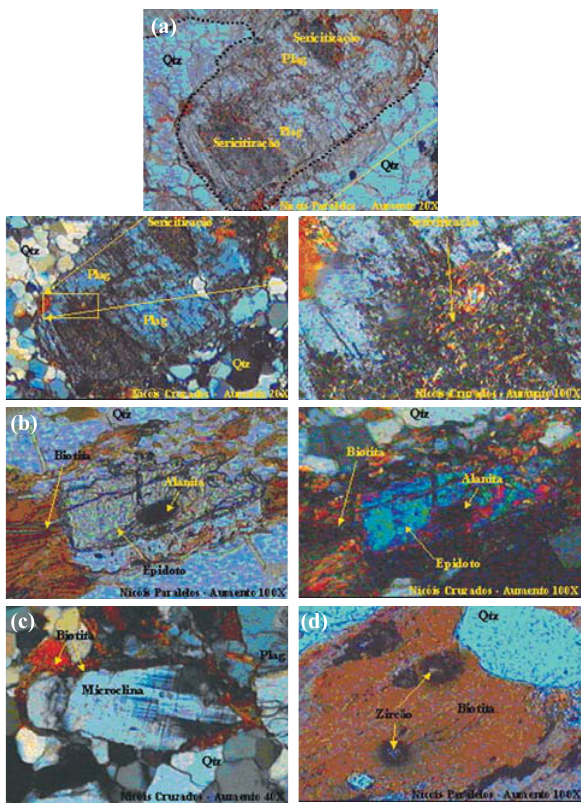
Figura 4. Fotomicrografias do material de origem: (a) processo de sericitização dos feldspatos plagioclásicos; (b) cristal de epidoto com núcleo alanítico e cristais de biotita; (c) aspecto geral da rocha matriz, constituída por plagioclásio (Plag), microclina, quartzo (Qtz) e biotita; (d) cristal de biotita com inclusões de zircão, mostrando halos pleocróicos (Op – minerais